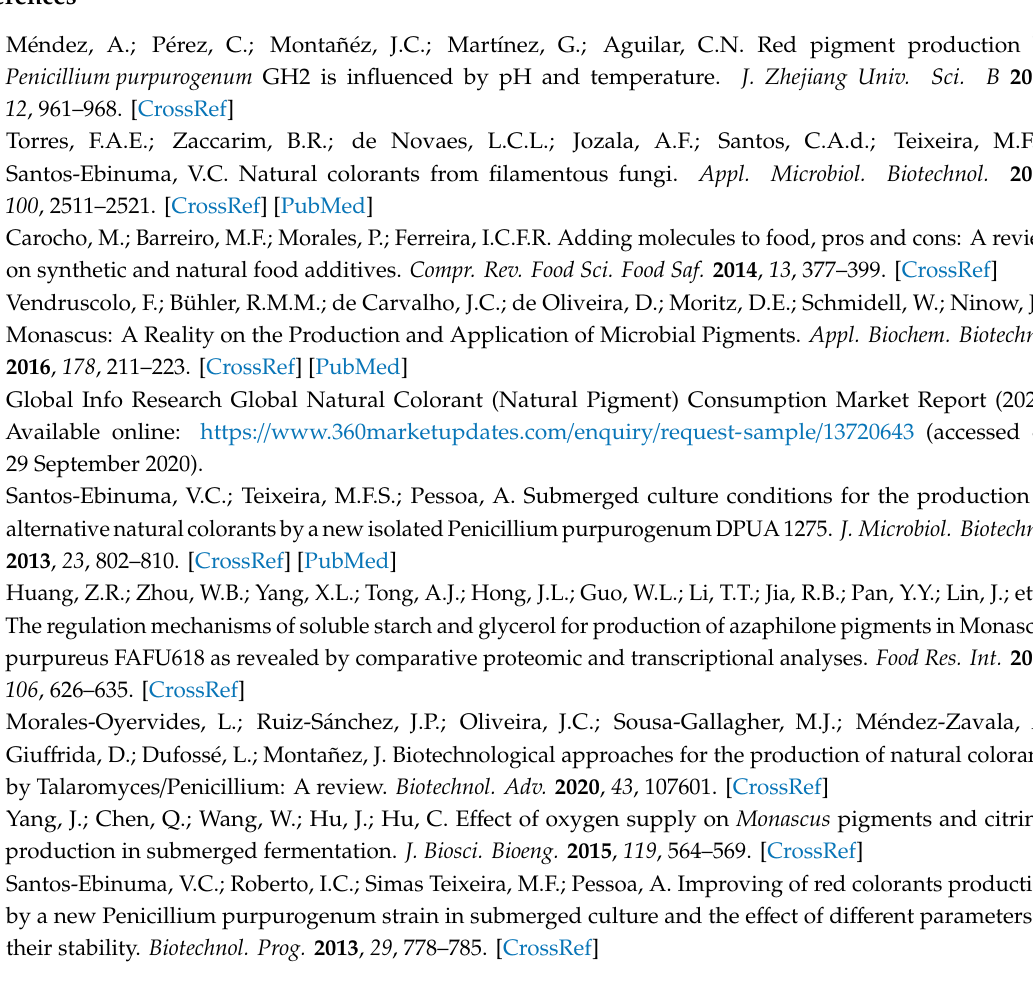
Figure S1: Butter packaged in cassava starch-based films with colorant additives (CFC), cassava starch-based films without colorant additives (CF), conventional plastic (CP), and unpackaged butter (U), Table S1: Consumption of sucrose and pH over time (0 to 240 h) of submerged culture of T. amestolkiae in stirred-tank bioreactor varying the stirring speed (100 to 600 rpm) at 2.0 vvm and 30 ◦ C, Table S2: Peroxide content in the butter as a function of the packaging film used, such as: cassava starch-based films with colorant additives (CFC), cassava starch-based films without colorant additives (CF), conventional plastic (CP), and unpackaged butter (U), during di ff erent periods of time (0, 7, 15, 30, and 45 days) in